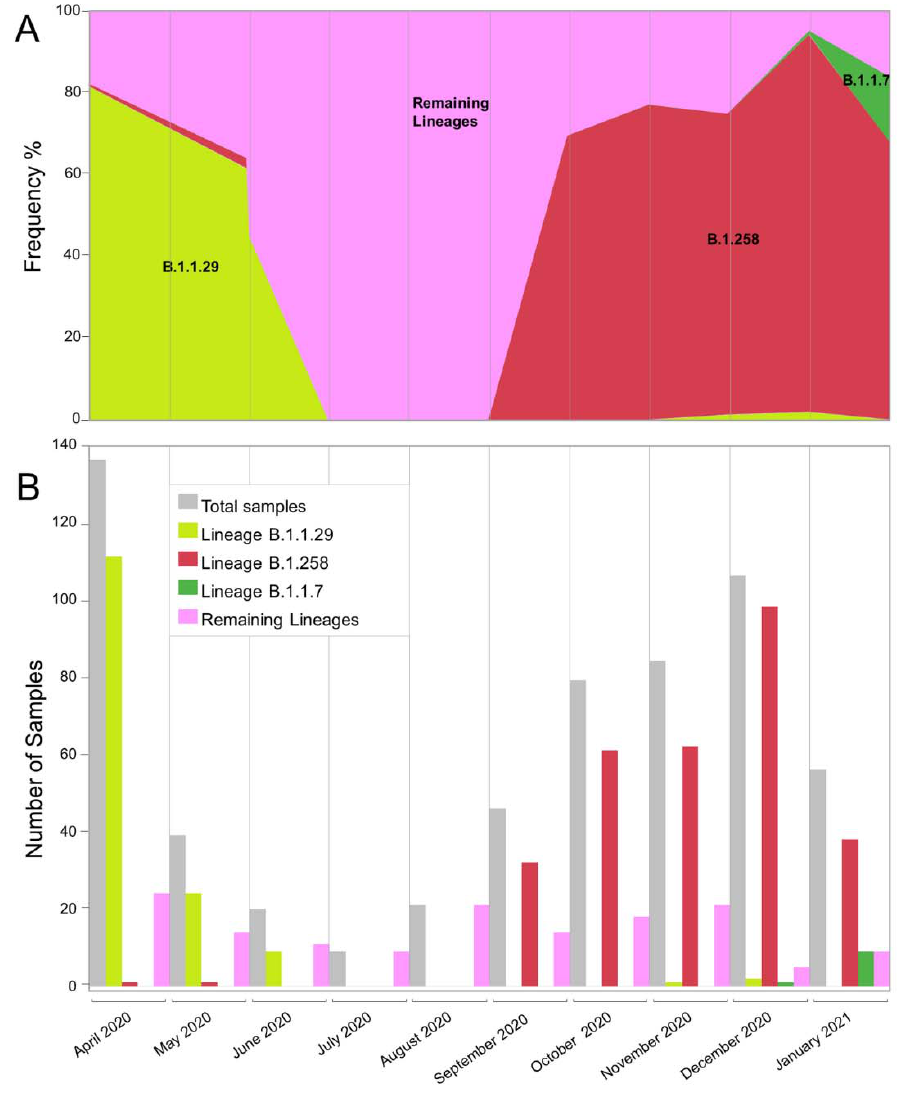
Figure 1. Graphical representation of the appearance of lineages B.1.1.29, B.1.258 and B.1.1.7 in each month of the sampling period from April 2020 to January 2021. ( A ) The frequency of the two most prevalent lineages, as well as B.1.1.7, over the 10-month sampling period. The y -axis represents the frequency of samples as percentages, while the x-axis represents the time-period of each month of the sampling period. The samples for lineages B.1.1.29, B.1.258, and B.1.1.7 are shown in light green, red and green, respectively. The numbers of samples in the remaining lineages are shown in pink and were calculated by excluding the monthly samples in the B.1.1.29, B.1.258, and B.1.1.7 lineages from the total number of samples (Table 1). ( B ) Bar chart indicating the number of samples of the two most prevalent lineages, as well as B.1.1.7, over the 10-month sampling period. The y-axis represents the number of samples that were identified in each month of the sampling period. The total number of samples is shown in gray (indicated in Table 1), and the samples belonging to lineages B.1.1.29, B.1.258, and B.1.1.7 are shown in light green, red and green, respectively. The numbers of samples in the remaining lineages are shown in pink and were calculated by excluding the monthly B.1.1.29, B.1.258, and B.1.1.7 lineage samples from the total number of samples (Table 1). The x -axis represents each month in the sampling period.